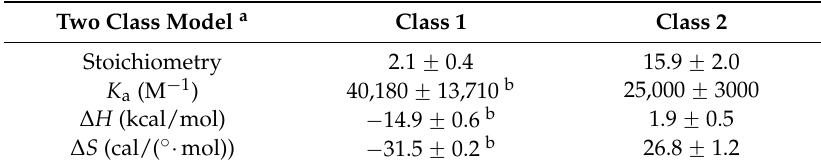
Figure 3. Van’t Hoff Analysis of Ion binding to the DNA 4WJ. The K a values were determined from temperature dependent FRET experiments that monitored junction conformation upon ion binding (Supplementary Material, Figure S2). Titrations were carried out in a solution of 50 nM 4WJ, 0.5 mM Na + and 10 mM Tris–HCl with pH 7.4. Table 1. Thermodynamic Parameters of Ion Binding.